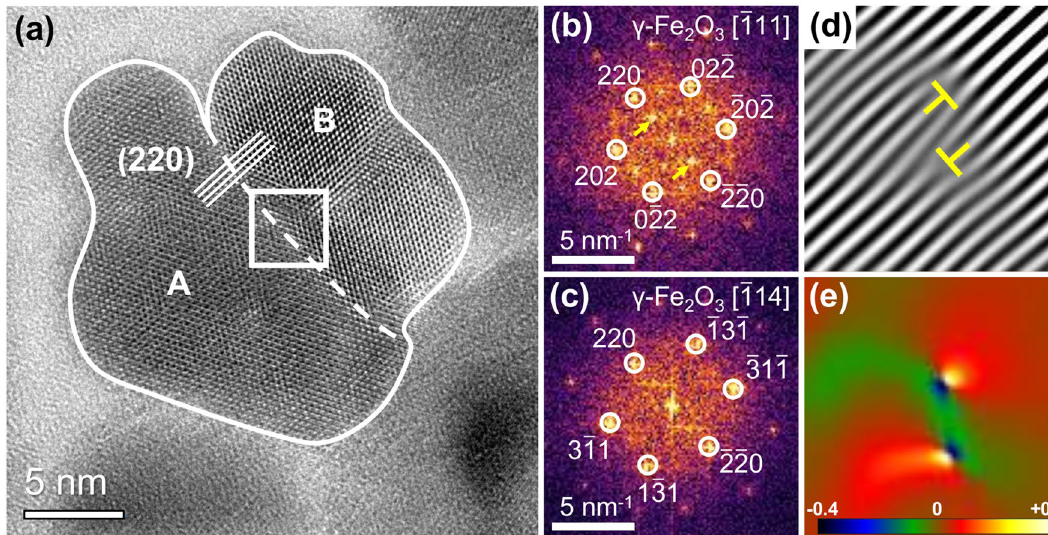
Figure 3. ( a ) HRTEM image of a double-core IONF. The outer boundaries of the individual cores and their interface are indicated by a solid line and by a dashed line, respectively. Panels ( b ) and ( c ) show local FFTs of the cores labeled A and B in ( a ), respectively. In panel ( b ), reflections associated with the ordering of vacancies are marked by arrows. ( d ) Filtered inverse FFT showing the ( 220 ) lattice fringes from the region in the middle of panel (a) that is marked by a square. ( e ) Strain field component perpendicular to the ( 220 ) lattice planes of the cores as determined by GPA.